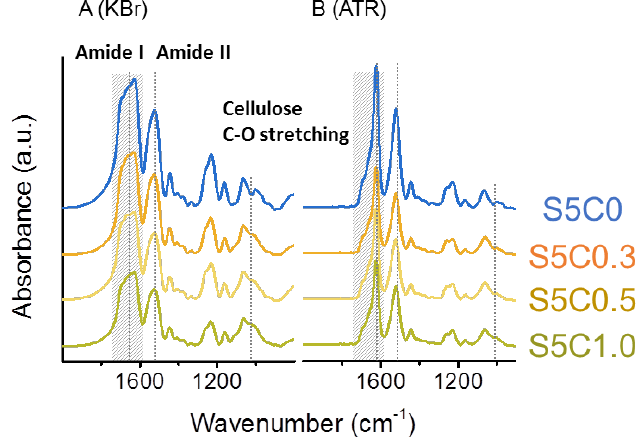
Figure 2. FTIR spectra of hydrogels. ( A ) Transmission (KBr) set up, ( B ) attenuated total reflectance (ATR) set up. Significant bands (amide I 1630 cm − 1 , amide II 1530 cm − 1 , cellulose C-O stretching 1019 cm − 1 ) are marked by dotted lines. Amide I peak area for deconvolution is marked in hatching.